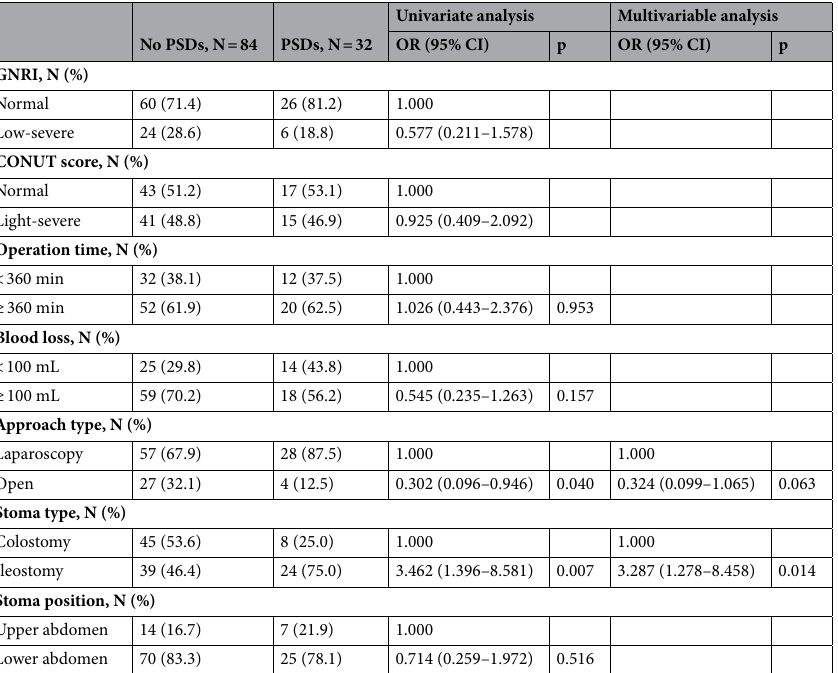
Table 2. Risk factors for all peristomal skin disorders. PSDs peristomal skin disorders, OR odds ratio, CI confidence interval, PNI prognostic nutritional index, GNRI geriatric nutritional risk index, CONUT Controlling Nutritional